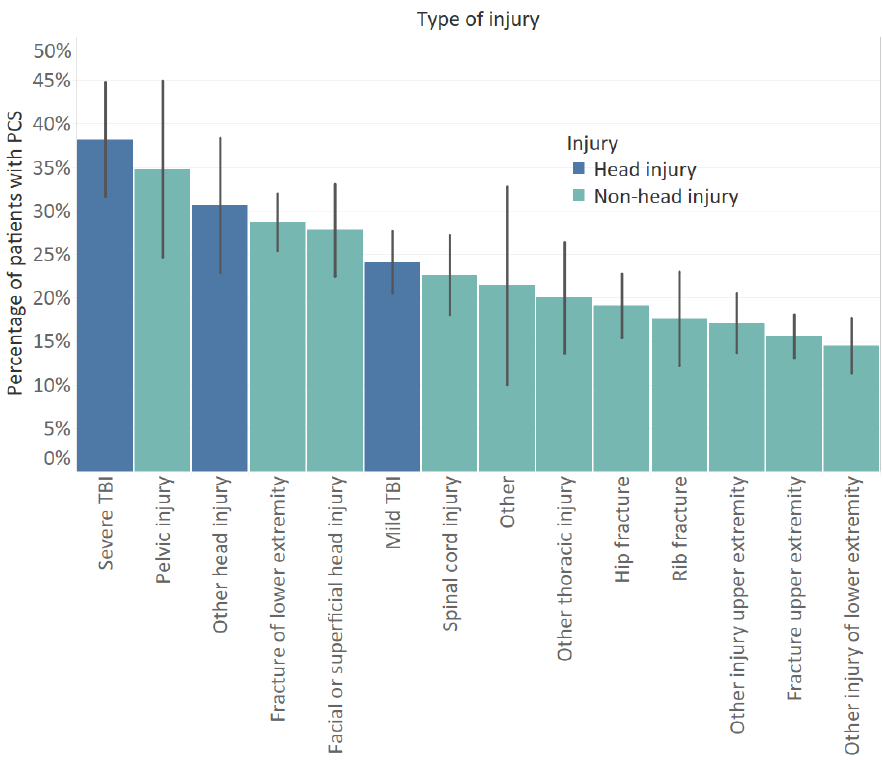
Figure 1. Percentage of patients with post-concussion syndrome ( ≥ 3 of the core post-concussion symptoms) for different injury groups. Error bars represent the standard error.